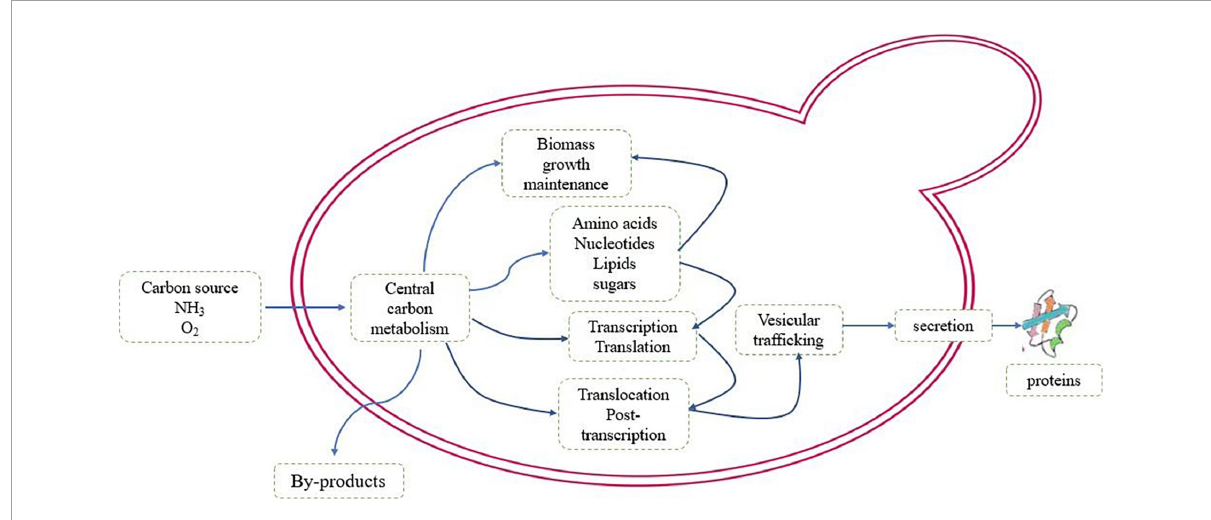
FIGURE1 The schematic of metabolic pathway of the recombinant protein